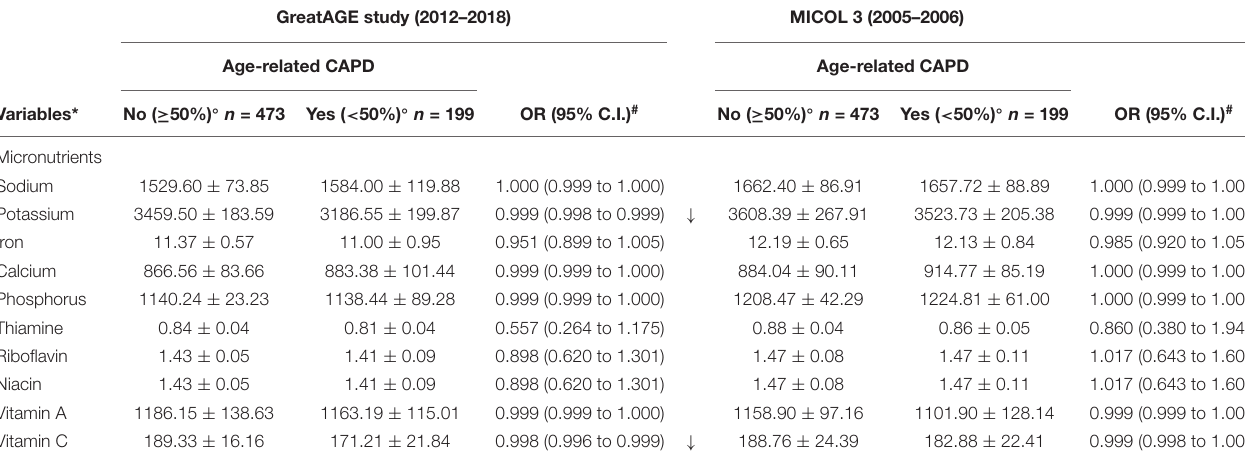
TABLE 3 | Micronutrient intake characteristics of the population at baseline (M3) and follow-up (GreatAGE study) ( n = 734, non-age-related CAPD n = 473, age-related CAPD n = 199, missing n = 62).